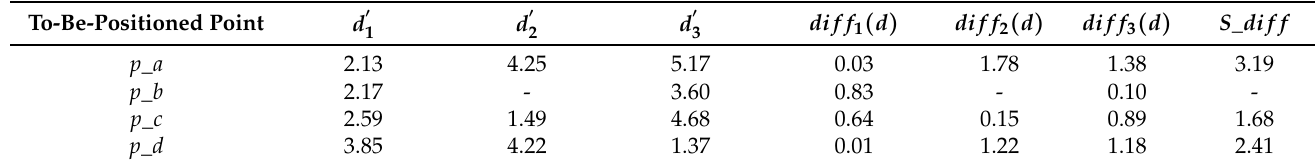
Table 6. Polynomial fitting ranging model ranging results and errors (m).